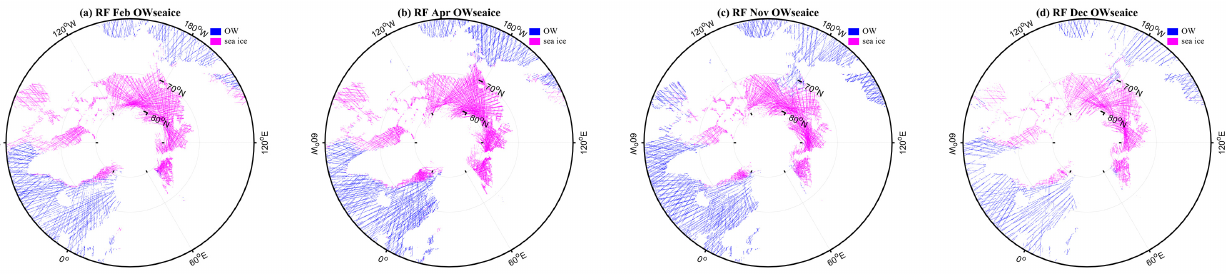
Figure A3. RF for OW-sea ice classification using the data in April as the training set. The data in ( a ) February, ( b ) March, ( c ) November, and ( d ) December are used as the test set in turn. Figure A4. RF for OW-sea ice classification using the data in November as the training set. The data in ( a ) February, ( b ) March, ( c ) April, and ( d ) December are used as the test set in turn.